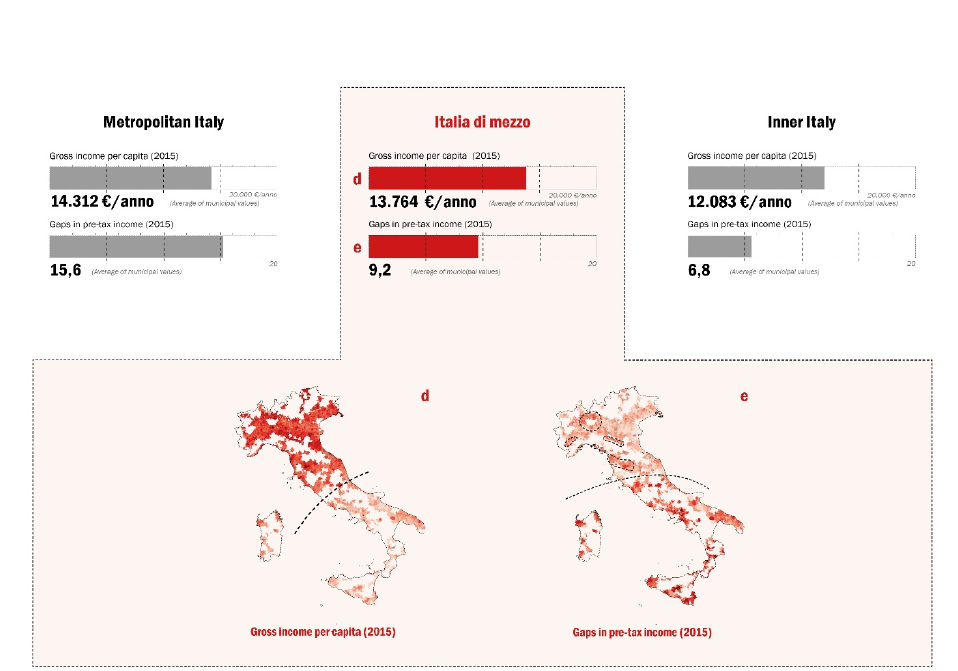
Figure 5: Italia di mezzo “in the middle” for some social